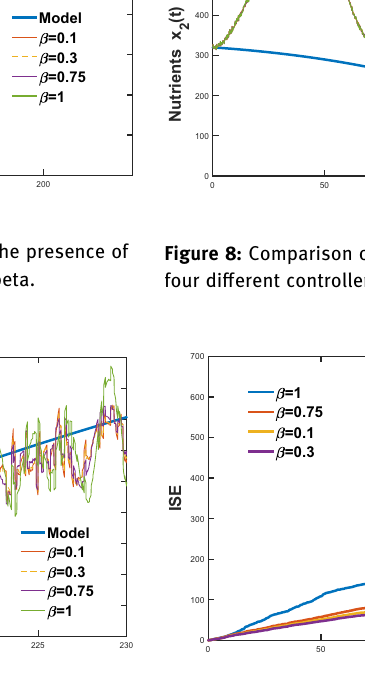
Figure 7: Comparison with Zoom of the biomass dynamics in pre - sence of the four di ff erent controllers with a change of the beta.